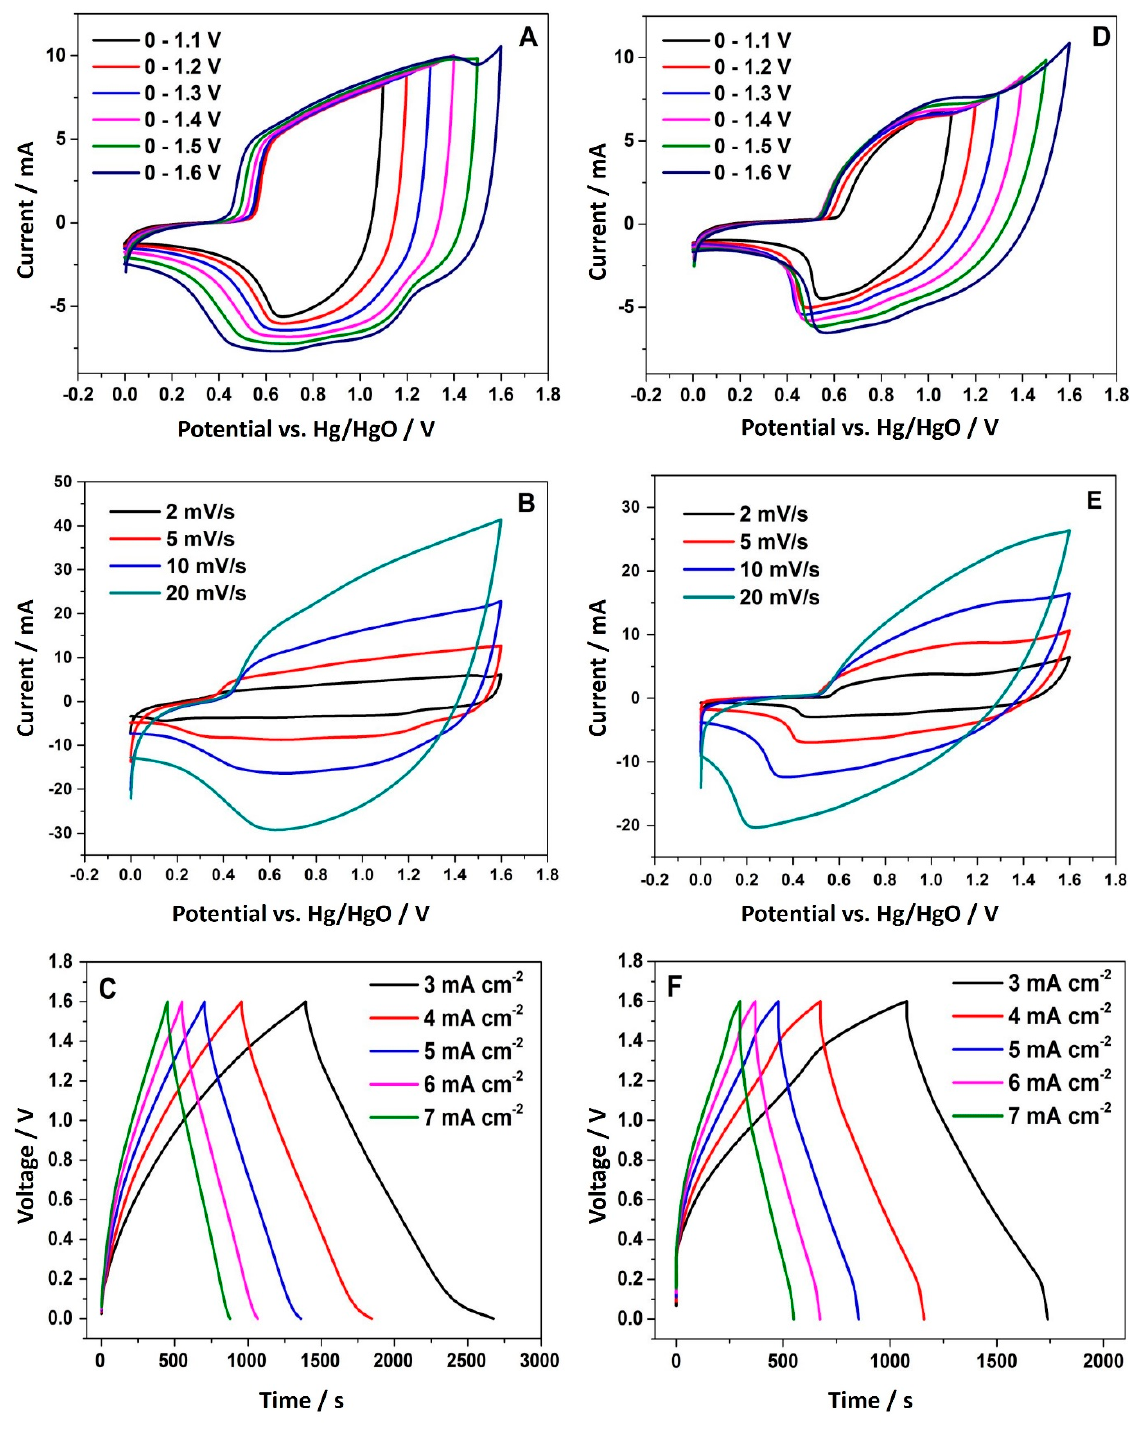
Figure 12. Electrochemical measurements of asymmetric cells: Cyclic voltammetric (CV) curves of NiMoO 4 ( A ) and NiWO 4 ( D ) at different potential windows at a scan rate of 5 mV s − 1 , CV curves of NiMoO 4 ( B ), and NiWO 4 ( E ) at different scan rates and galvanostatic charge-discharge (CD) profile of NiMoO 4 ( C ) and NiWO 4 ( F ) at different applied currents. To obtain further insights on the charge transport behavior of both materials, electro- chemical impedance spectroscopy (EIS) was performed (Figure 13A). The fitted equiva- lent circuit for both Nyquist plots is shown in the inset. Each plot shows two distinct re- gions: a semi-circle in the high-frequency area corresponds to R ct (charge transfer re- sistance) and R s (solution resistance) of the hybrid cell, followed by a linear region in the